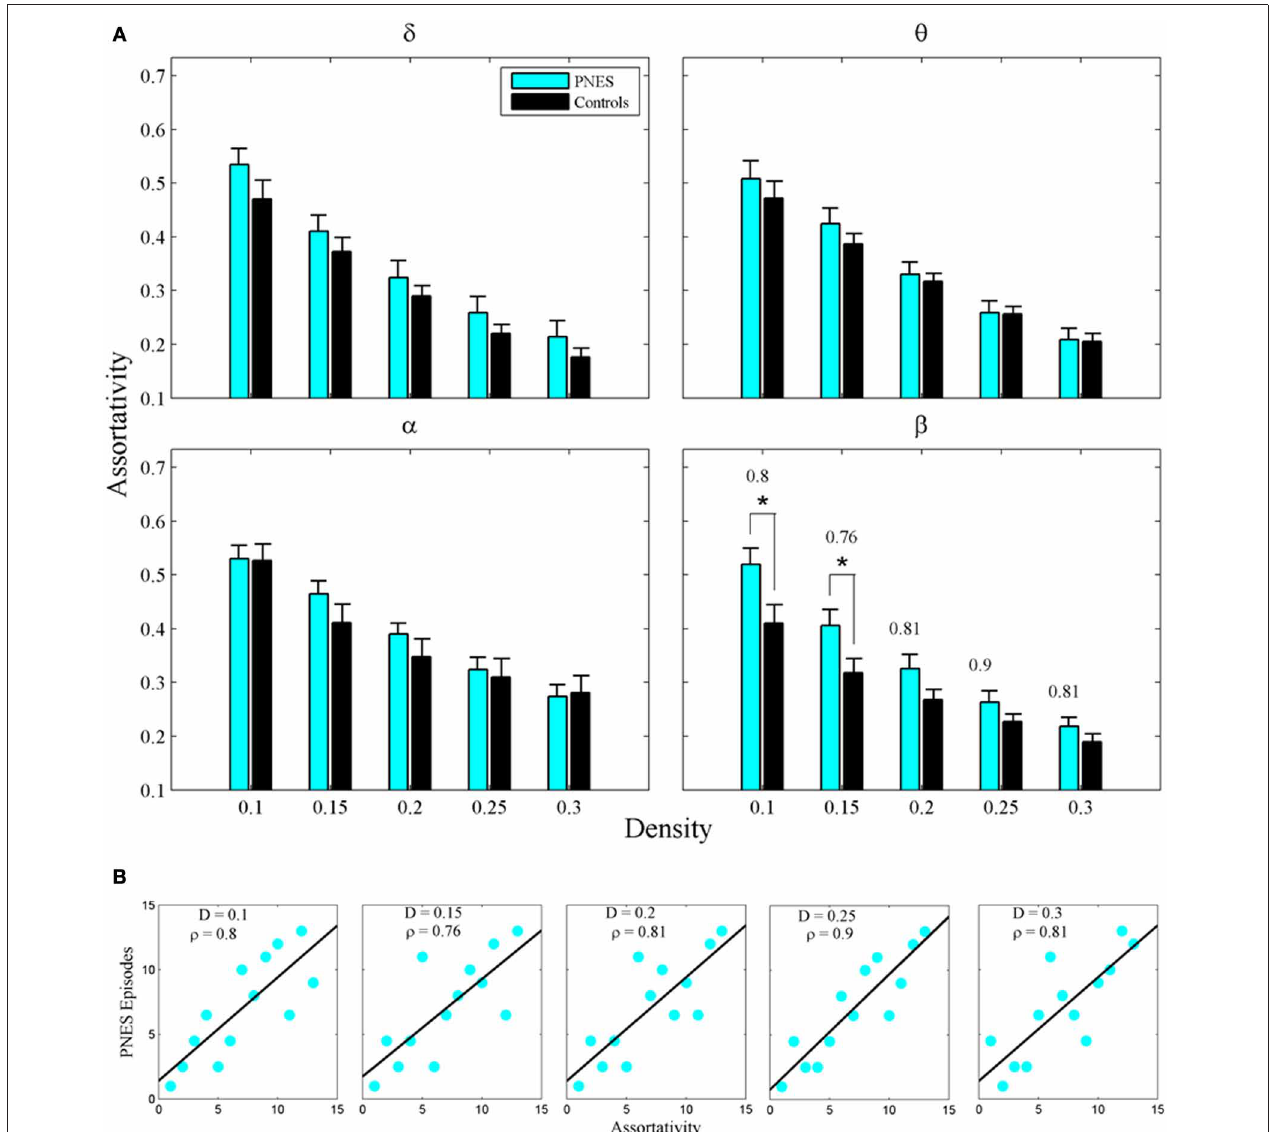
FIGURE 5 | Assortativity as a function of network density for PNES patients and controls. (A) The plots show the assortativity of functional brain networks as a function of density in PNES patients and controls. Asterisks indicate that PNES clustering co-efficient is significantly different